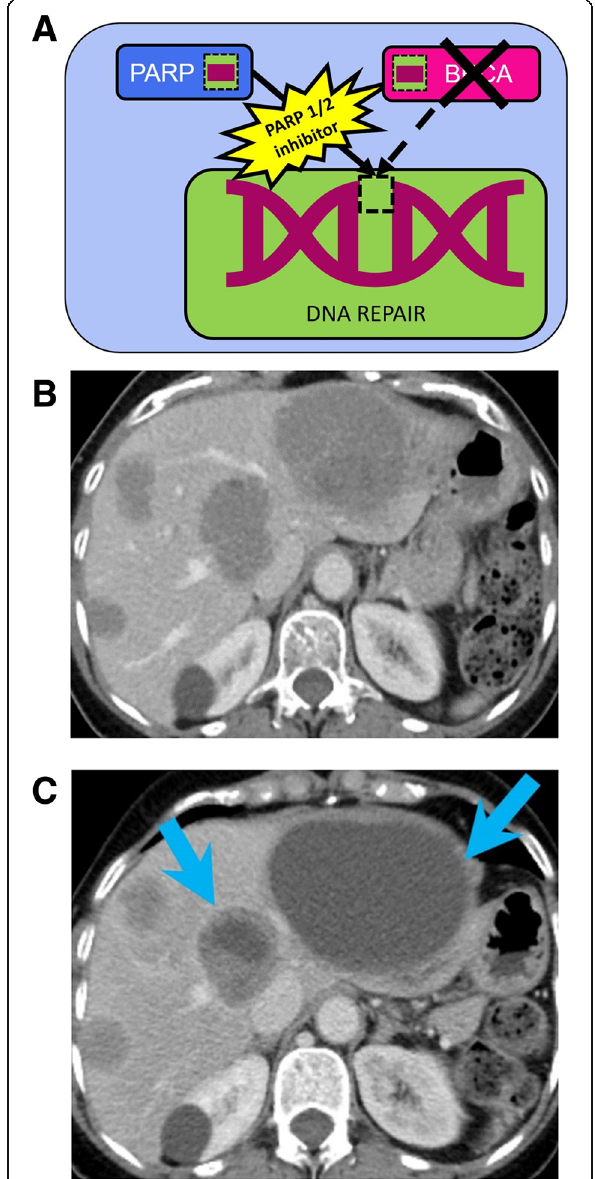
Fig. 6 Genome maintenance and DNA damage control pathway. a Image showing the role of poly (ADP-ribose) polymerases (PARP) in DNA repair. PARP1 and PARP2 repair DNA single- or double-DNA strand breaks. In patients with BRCA loss-of-function mutations, PARP 1/2 inhibitors, such as niraparib, are particularly effective as BRCA contribute to DNA repair. b , c CT of the abdomen in 65-year-old woman with platinum resistant ovarian cancer on treatment with niraparib. a Baseline contrast-enhanced CT image before starting niraparib shows multiple hypodense large liver metastases. b Follow- up contrast-enhanced CT image performed two months after starting the treatment shows decreased enhancing component of the various lesions (arrows in c ), with minimal interval increase in size in some of the lesions, representing atypical response to